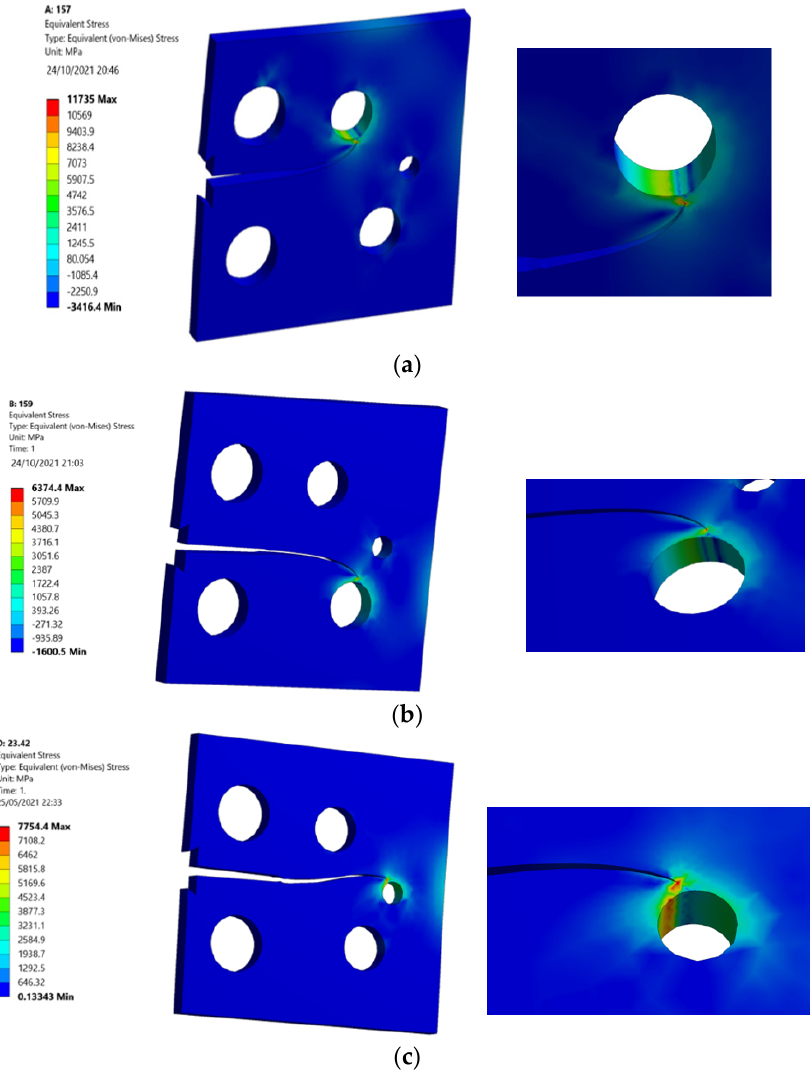
Figure 7. Von Mises stress distribution of ( a ) specimen 1, ( b ) specimen 2, and ( c ) specimen 3.